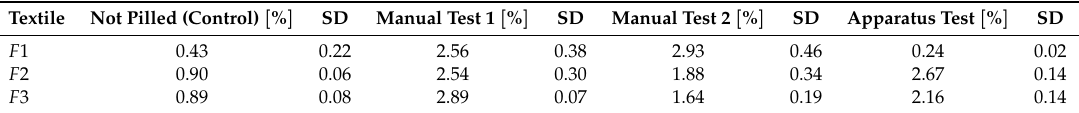
Table 2. Fraction f P of fiber voxels (bright pixels in OCT image) counted in the pilling layer L P of fabrics subjected to friction tests.